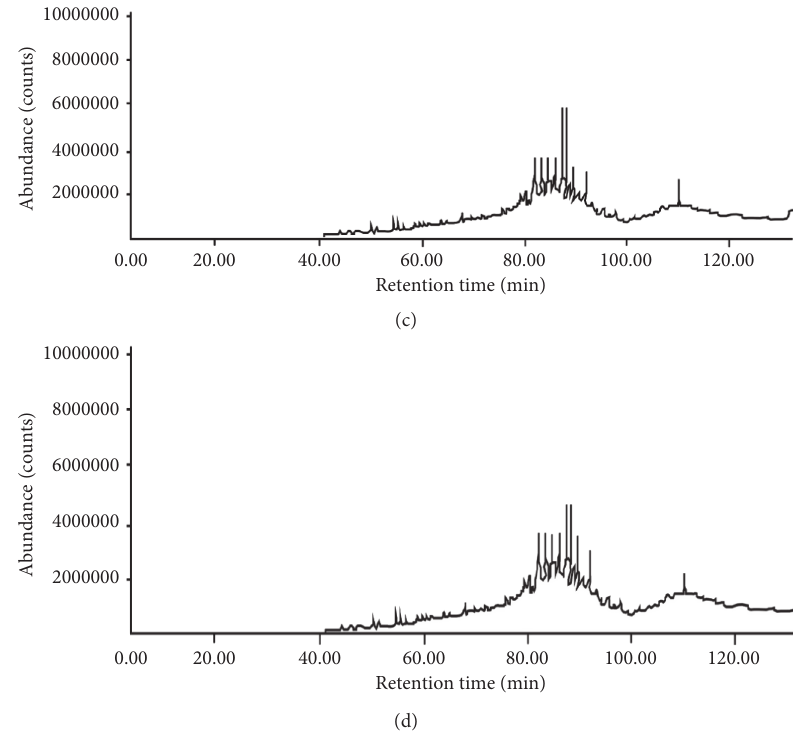
Figure 2: Total ion chromatograms (TIC) of the TPH extracts of the control and treatments during the bioremediation experiment after 120 days. (a) No treatment. (b) Treated with plants. (c) Treated with plant and manure 5gkg − 1 soil. (d) Treated with plant and manure 10gkg − 1